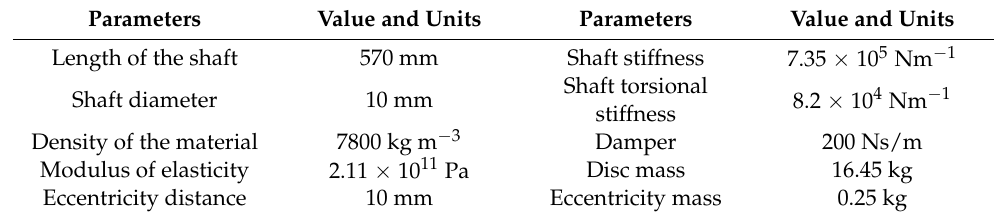
Table 1. Rotor system RK4